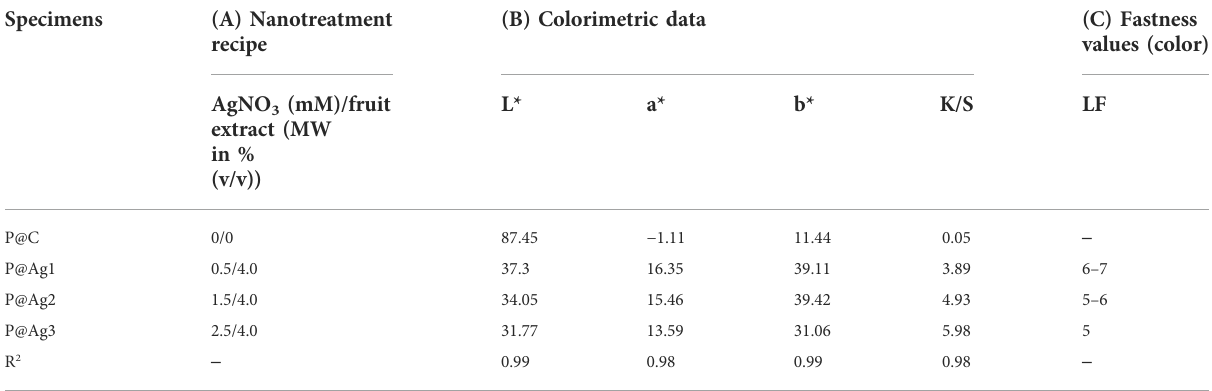
TABLE 2 Colorimetric data for control and AgNP-treated kraft